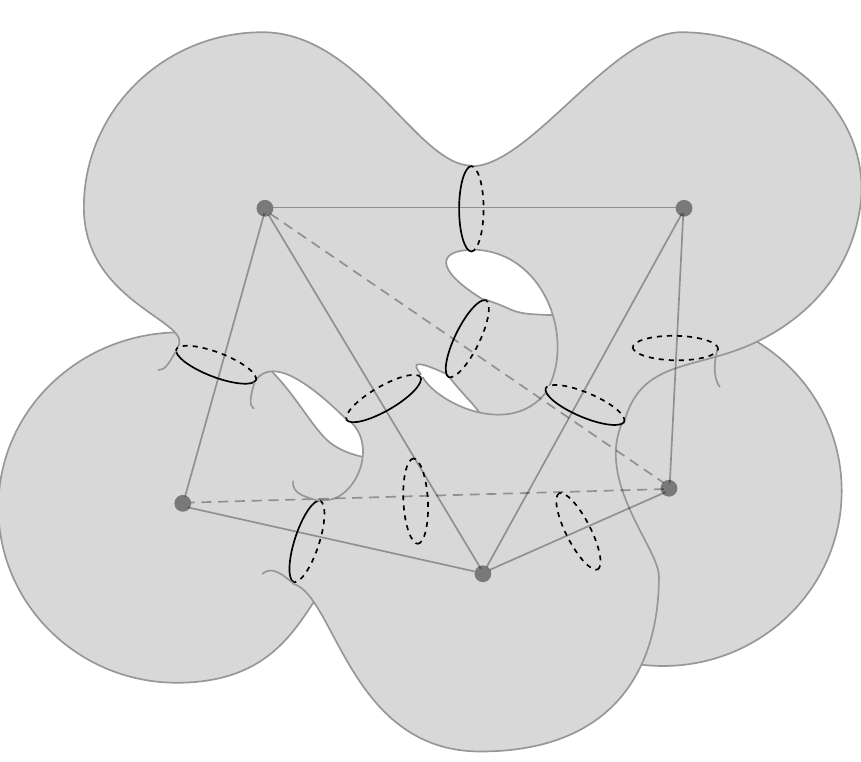
Figure 27 . The second step of a swiss cheese construction: we connect the holes by tubes running along the edges of the triangulation. A special line is added around the tubes to make them trivial.